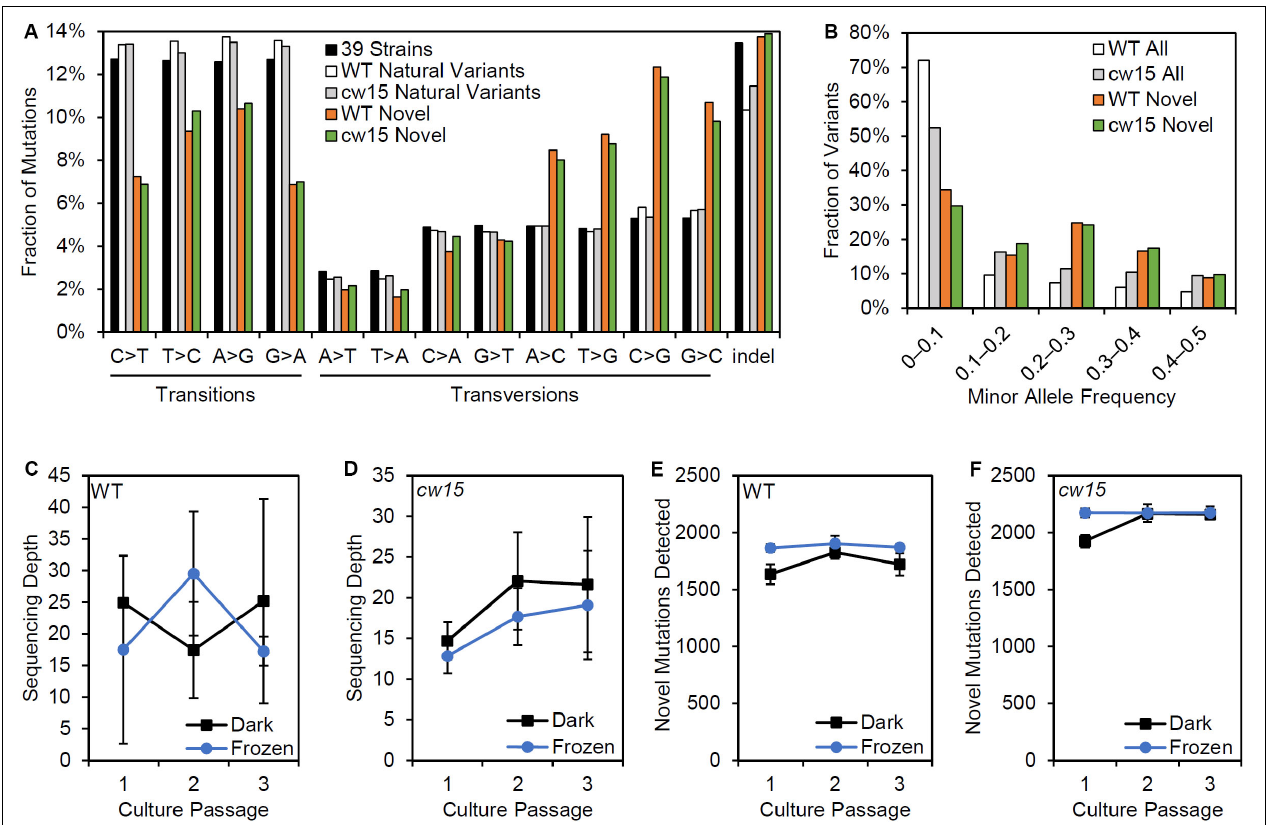
FIGURE 6 | Effects of variant filtering and live culture storage on mutations detected. (A) Relative frequency of base changes and indels for natural variants found by Gallaher et al. (2015) and the novel variants after UV mutagenesis. (B) Minor allele frequency distribution for all variants and novel variants. (C,D) Average sequencing depth of three biological replicate libraries prepared from dark stored cultures and algae pellets that were frozen at the time of passage. (E,F) Average number of novel mutations detected in libraries from dark stored and frozen tissues. Error bars are standard deviations.